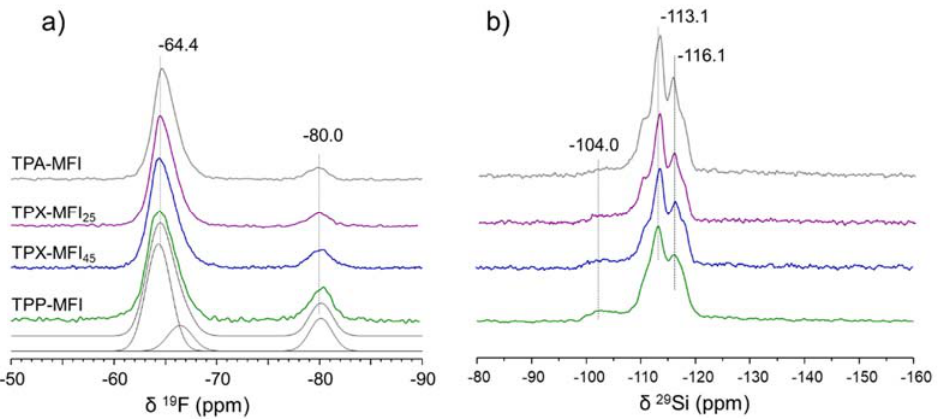
Figure 7. 19 F and 29 Si MAS NMR spectra of silicalite-1 samples synthesized using different OSDAs: ( a ) 19 F MAS NMR of the zeolites prepared with TPA, TPP (including the deconvolution of the spectra) and mixtures of them; ( b ) 29 Si MAS NMR of the same zeolites.